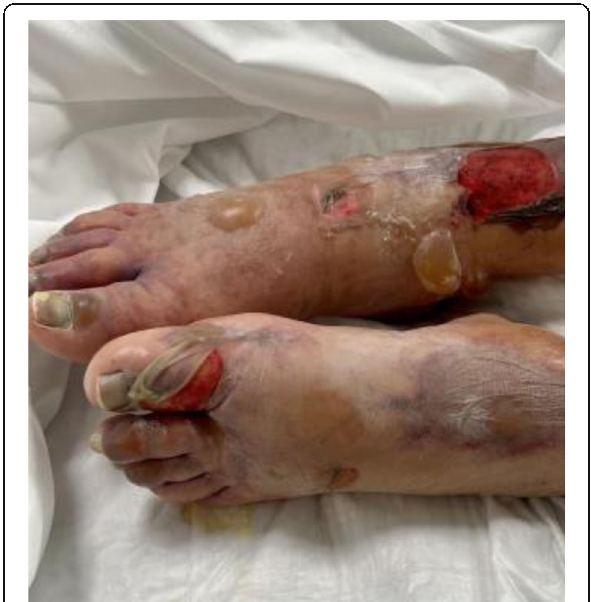
Fig. 2 (abstract A98). See text for description